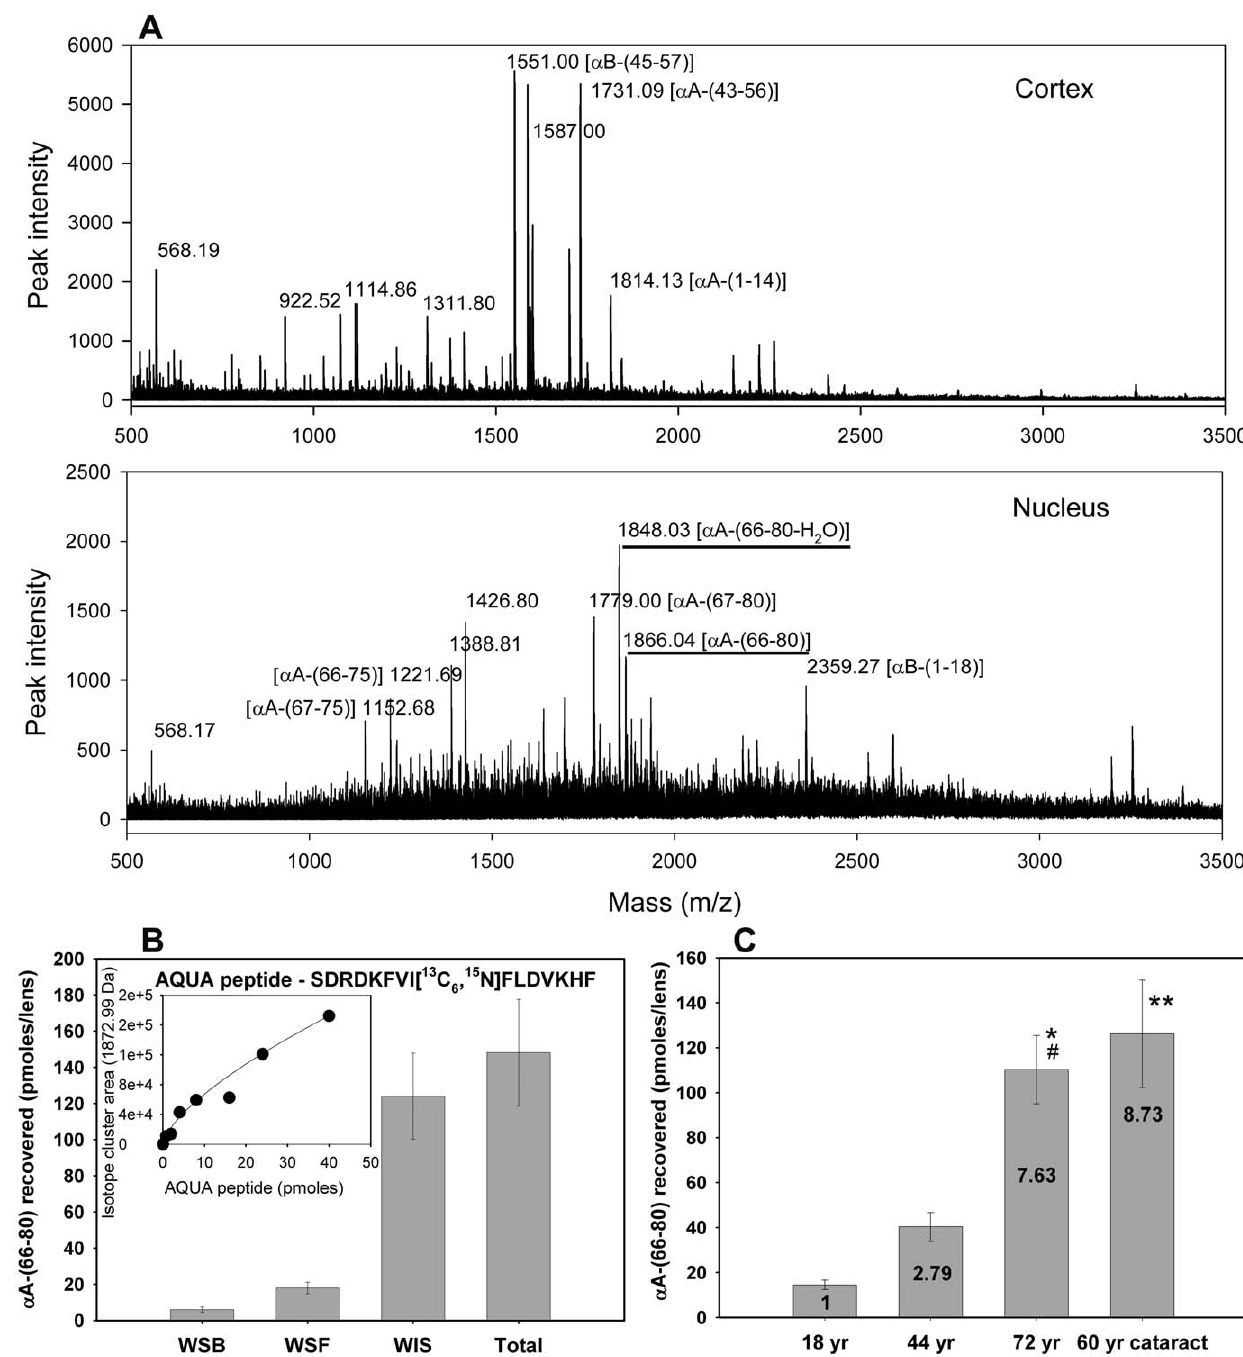
Figure 1. Distribution of the a A-(66-80) peptide in the lens. (A) MALDI qTOF MS/MS analysis of LMW peptides isolated from the cortex and nucleus of a . 70-year-old human lens as described under methods. The a A-(66-80) peptide characterized in this study is highlighted in the panel labeled – nucleus. (B) a A-(66-80) peptide concentrations in a . 70-year-old lens fractions (WSB, water-soluble bound; WSF, water-soluble free; WIS, water-insoluble sonicated fractions). The amount of the peptide was estimated using 13 C 15 N-labelled spiked synthetic peptide standards (AQUA peptide) during peptide isolation. The inset figure is the standard curve for the isotope cluster area of the AQUA peptide used to determine in vivo peptide concentration. (C) Concentrations of a A-(66-80) peptide in human lenses of 18-, 44-, 60- and 72-year age groups. Lenses that were 60 years old were cataract lenses. Values within the bar show the multiple increased concentrations as compared to the 18-year-old lens. The values are mean 6 SD of three analyses. * P , 0.001 compared to 18 year, # P , 0.01 compared to 44 year, ** P , 0.001 compared to 18 and 44 year. P value determined using ANOVA. These results show an age-dependent increase in the concentration of a A-(66-80) peptide in human lenses and these peptides are associated with the WIS fraction. The cataract lenses show a higher level of a A-(66-80) peptide than the expected level of the peptide in age-matched non-cataract lenses.